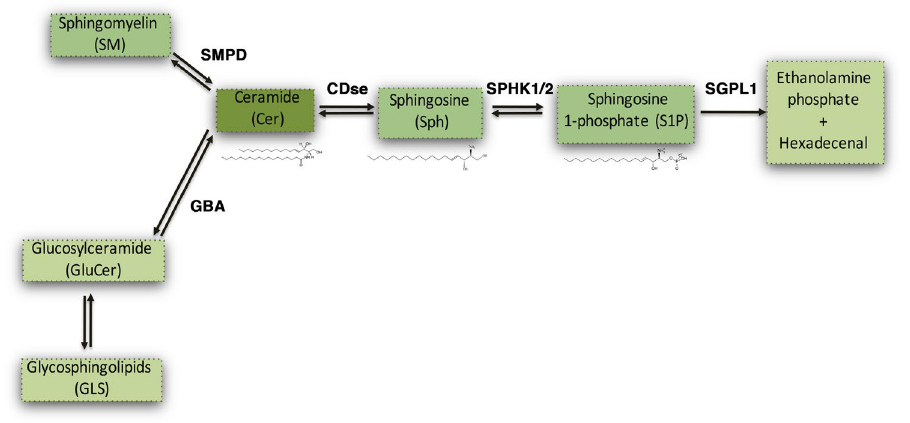
Figure 1. Simplified sphingolipid metabolic pathway. Ceramide (Cer) is generated through the degradation of either Sphingomyelin (SM) or Glycosphingolipids(GLS) by Sphingomyelin Phosphodiesterase (SMPD) and GlucosylCeramidase (GBA) respectively. Cer is subsequently metabolized by Ceramidase (CDse) to generate Sphingosine (Sph), which in turn produces Sphingosine-1-Phosphate (S1P) through phosphorylation by Sphingosine Kinase-1 and Sphingosine Kinase-2 (SPHK1/2). All these reactions are reversible. S1P can be catabolized into hexadecenal and phospho-ethanolamine by S1P Lyase (SGPL1).